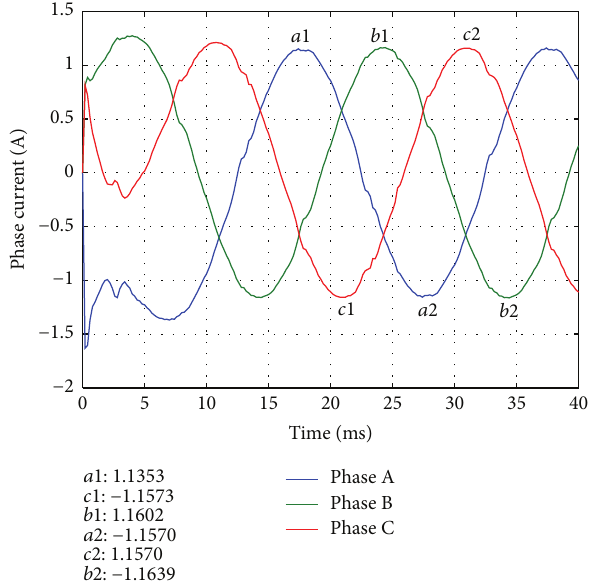
Figure 9: Phase current waves under normal condition.